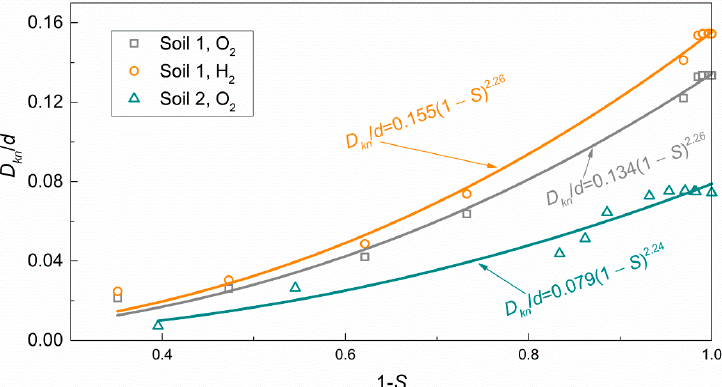
Figure 11. Increase of the normalized effective diffusion coefficient with gas saturation follows a power law.